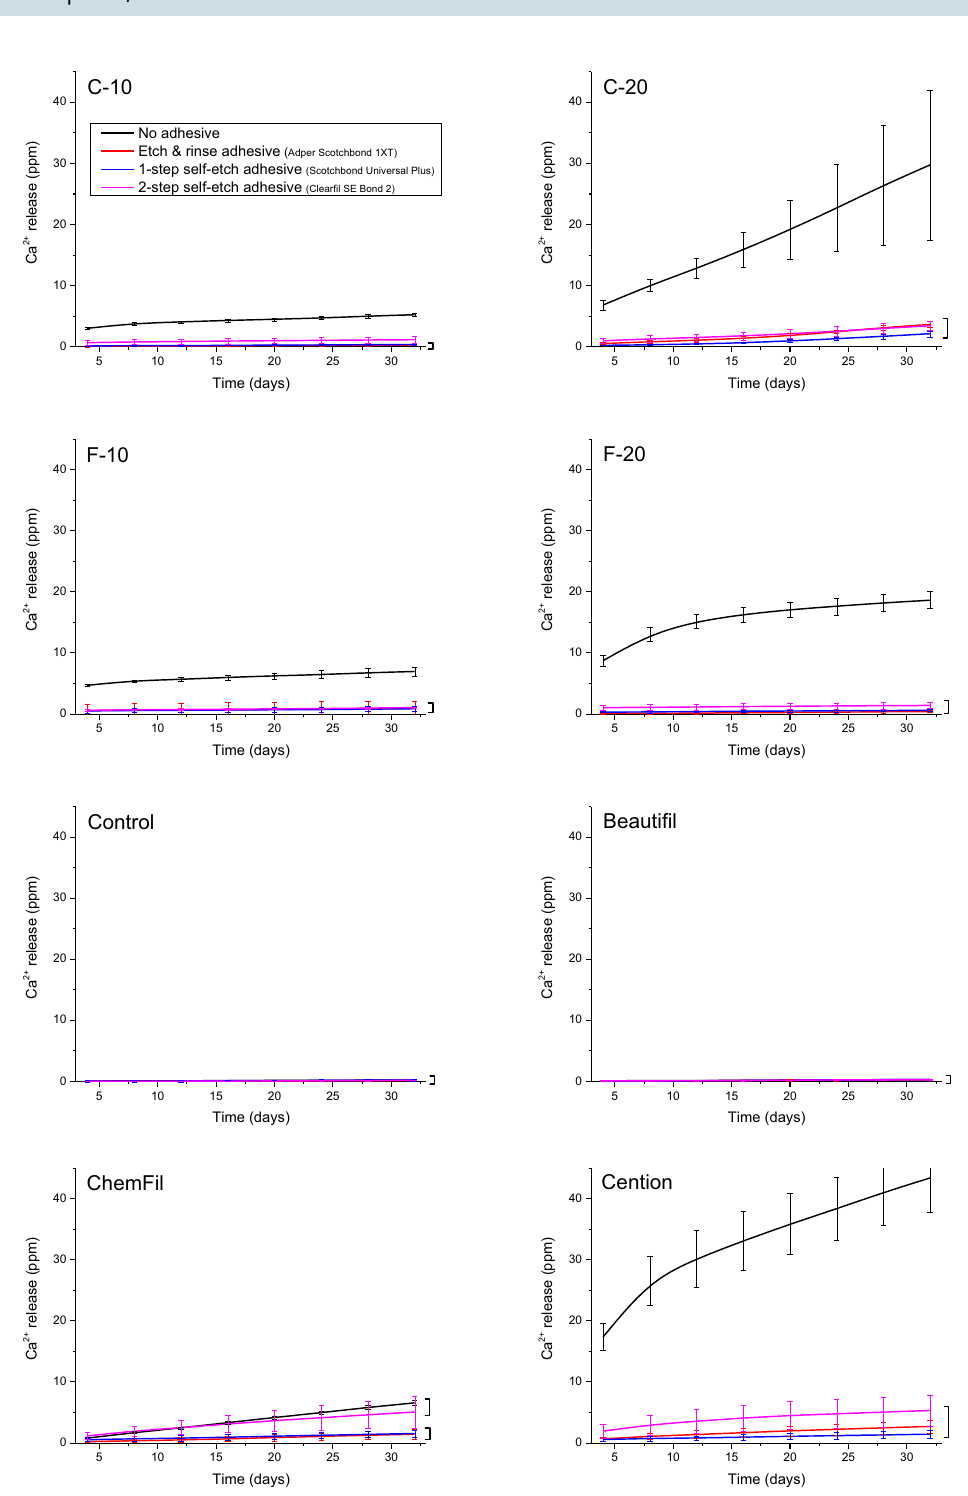
Figure 2. Cumulative concentrations of calcium ions measured in lactic acid solution over 32 days. Square brackets indicate statistically similar values at the end of the observation